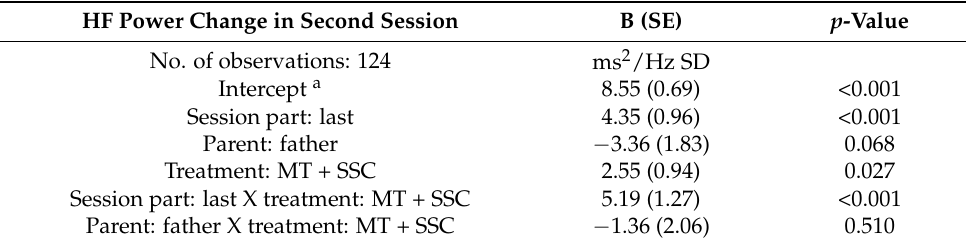
Table 2. Linear mixed effects (LME) model of primary outcome—high-frequency (HF) change in the second